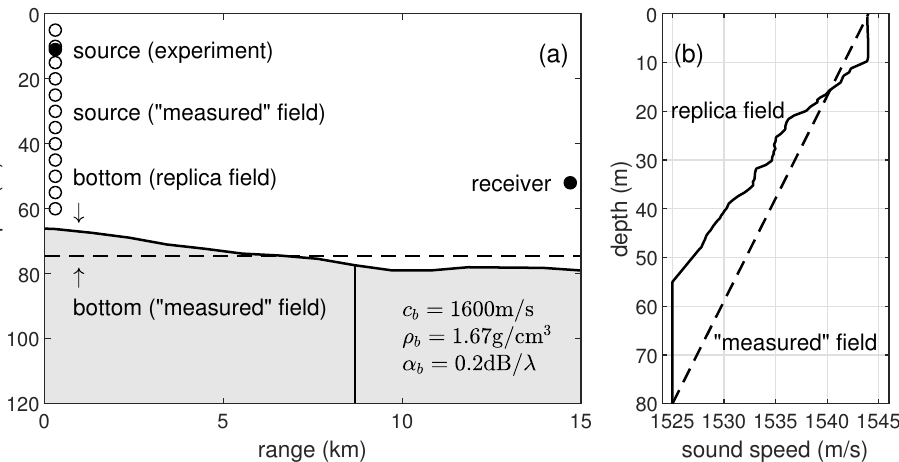
Figure 1. The nominal waveguide environment between the receiver site and the 5th source site in the experiment which was utilized to produce replica fields. Dashed lines in ( a , b ) represent the bathymetry and SSP to produce “measured”